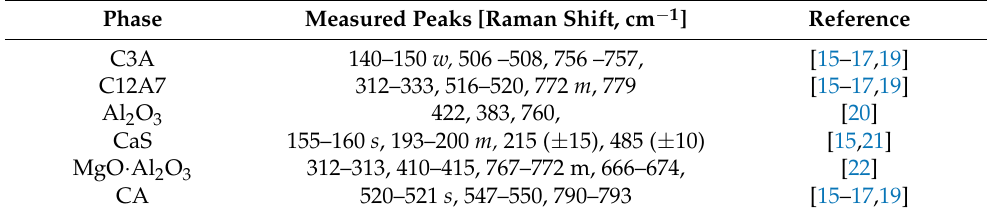
Figure 1. The Raman spectra for CA, Al 2 O 3 , MgO · Al 2 O 3 , C3A, CaS, and C12A7 obtained from synthetic phases prepared in previous studies [15–21]. Table 1. Raman peak positions were used to identify the inclusion phases in samples measured with Raman spectroscopy in this study (where s denotes strong, m is medium, and w is weak).